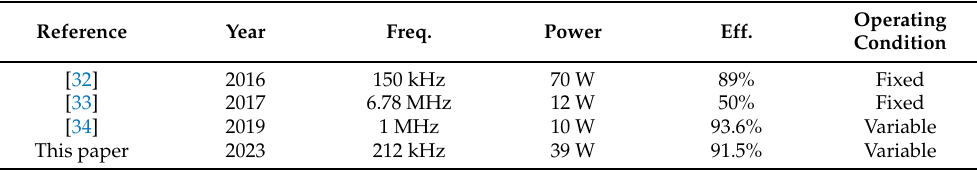
Table 3. DTC-WPT experimental